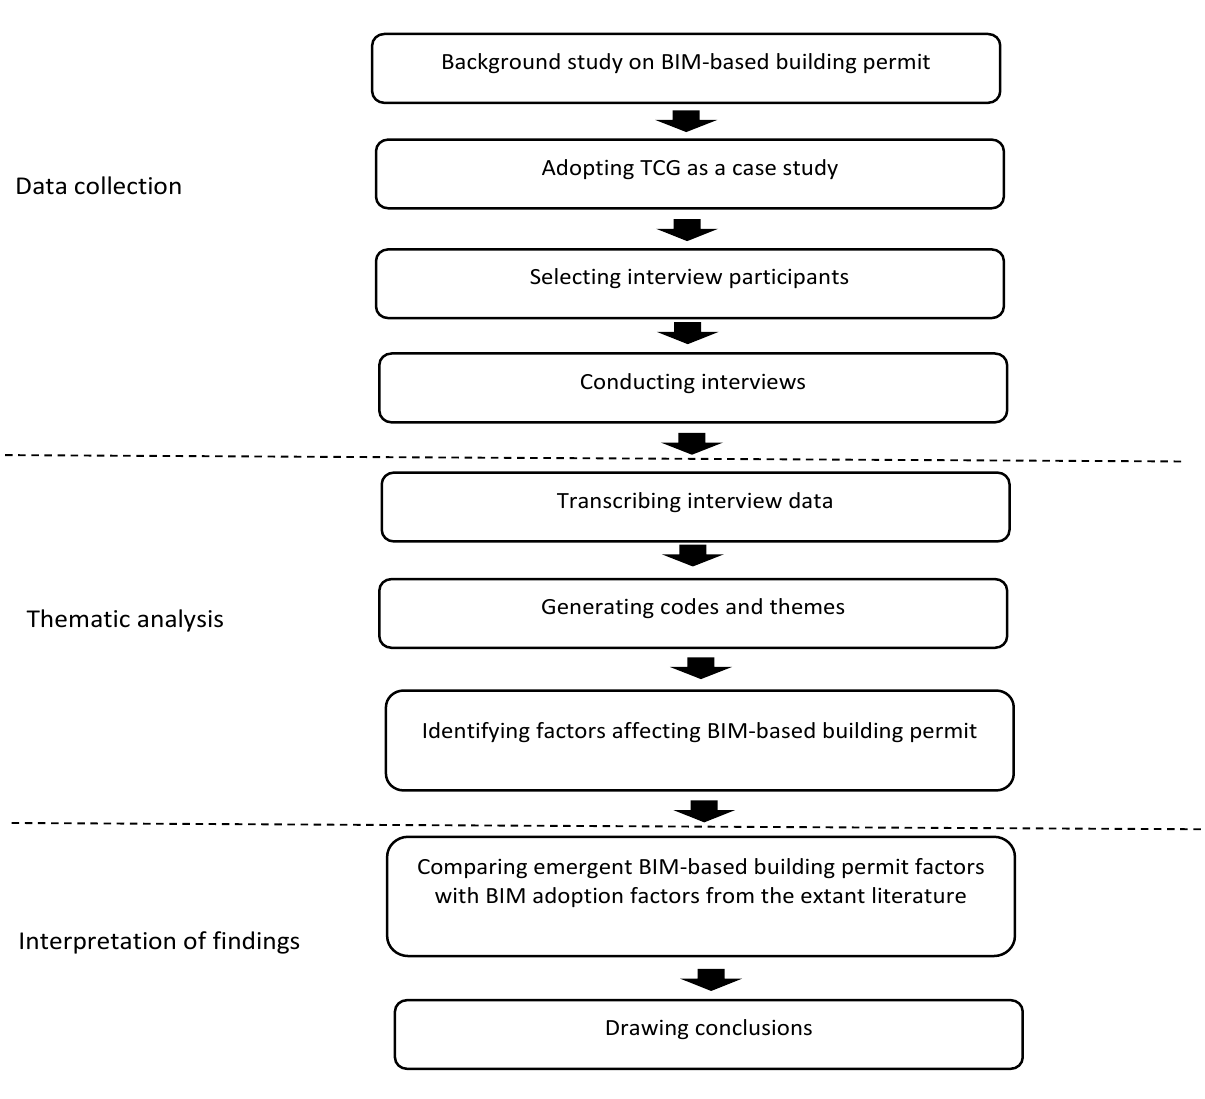
Figure 2. Methodological flow chart.